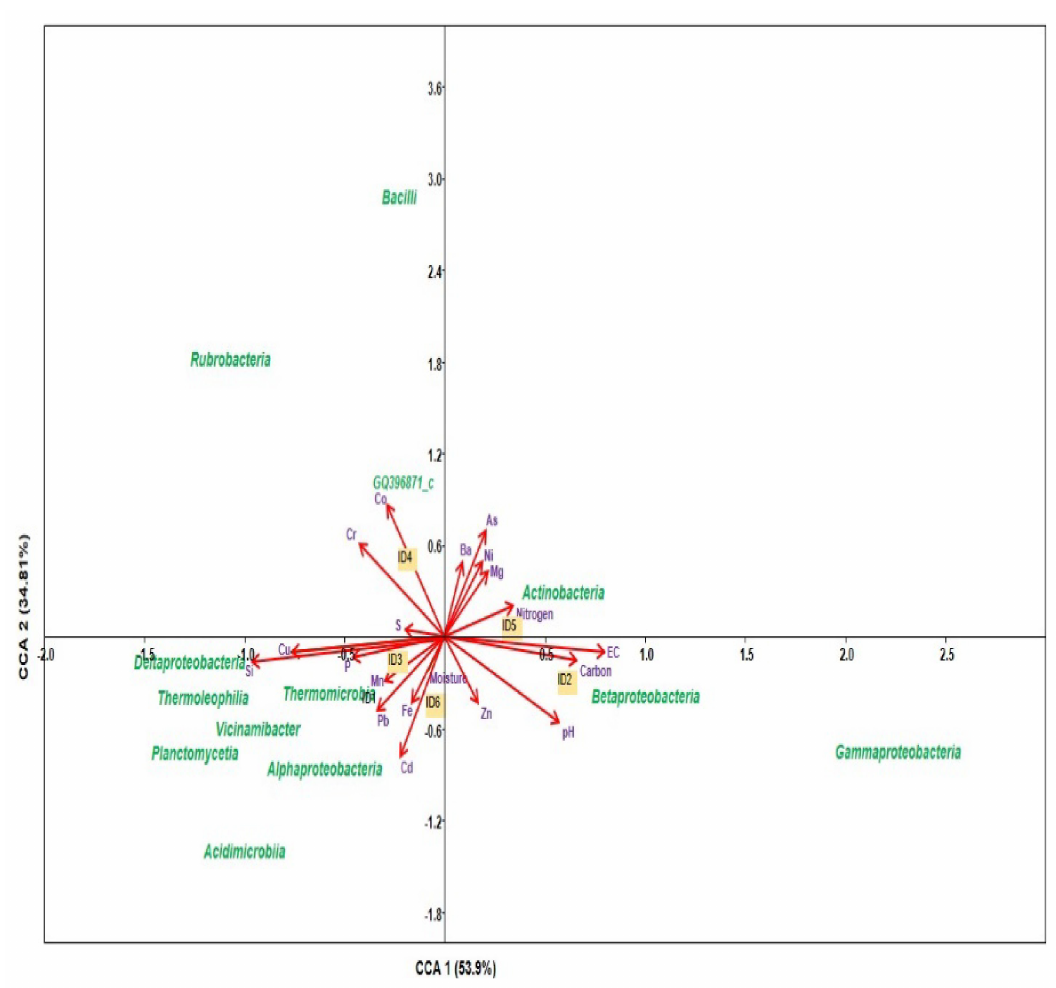
Figure 3. Canonical correspondence analysis (CCA) showing the relationship between microbial abundance and the measured environmental